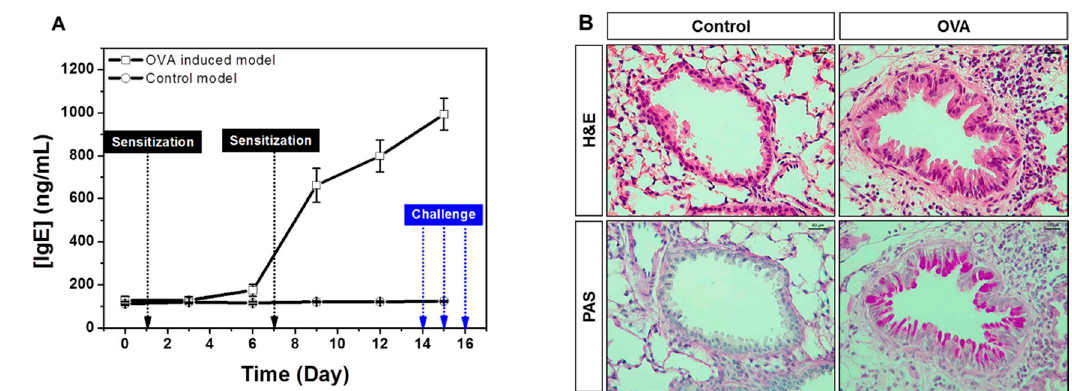
Figure 3. ( A ) Sequential monitoring of total IgE with blood ( B ) histologic changes in OVA-induced